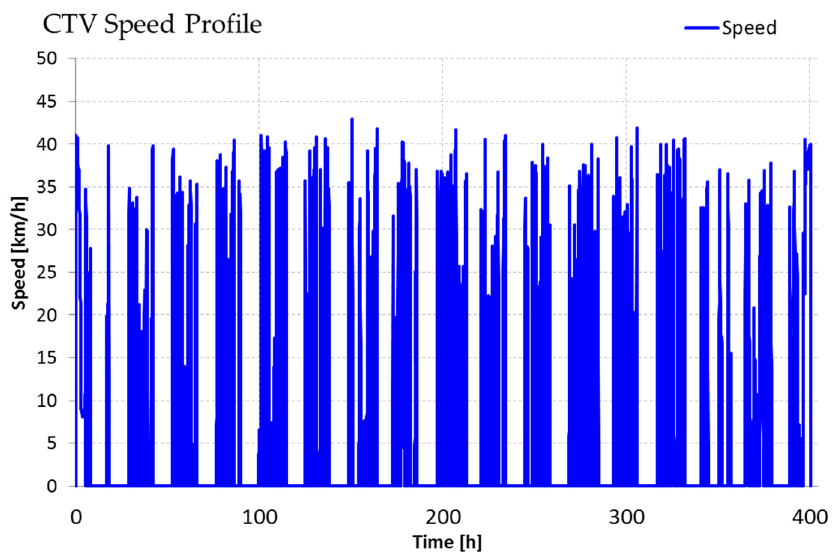
Figure 13. Catamaran speed profile set for the test route.